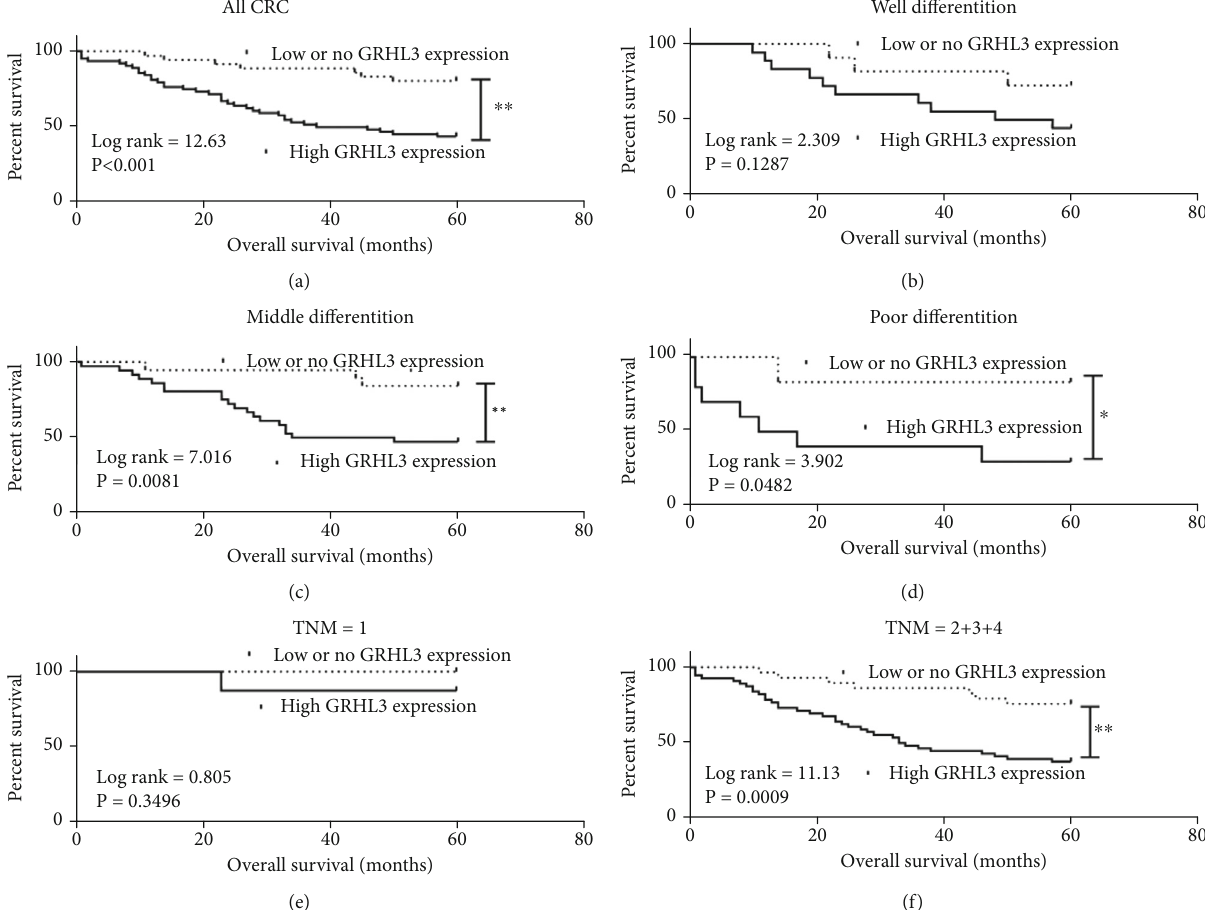
Figure 2: The Kaplan-Meier survival analysis of CRC patients. (a) The Kaplan-Meier survival analysis of CRC patients ( n = 100 ), including 64 high GRHL3 expression and 36 low GRHL3 expression according to GRHL3 immunostaining scores: score < 6 is low GRHL3 expression and score ≥ 6 belongs to high GRHL3 expression. ∗∗ P < 0 : 01 versus the low or no GRHL3 expression. (b) The Kaplan-Meier survival analysis of well di ff erentiation in CRC patients. (c) The Kaplan-Meier survival analysis of middle di ff erentiation in CRC patients. ∗∗ P < 0 : 01 versus the low or no GRHL3 expression. (d) The Kaplan-Meier survival analysis of poor di ff erentiation in CRC patients. ∗ P < 0 : 05 versus the low or no GRHL3 expression. (e) The Kaplan-Meier survival analysis of TNM = 1 in CRC patients. (f) The Kaplan-Meier survival analysis of TNM > 1 in CRC patients. ∗∗ P < 0 : 01 versus the low or no GRHL3 Table 2: Prognostic factors for overall survival in CRC patients obtained from univariate/multivariate analysis. Univariate analysis Multivariate analysis Item HR (95% CI)